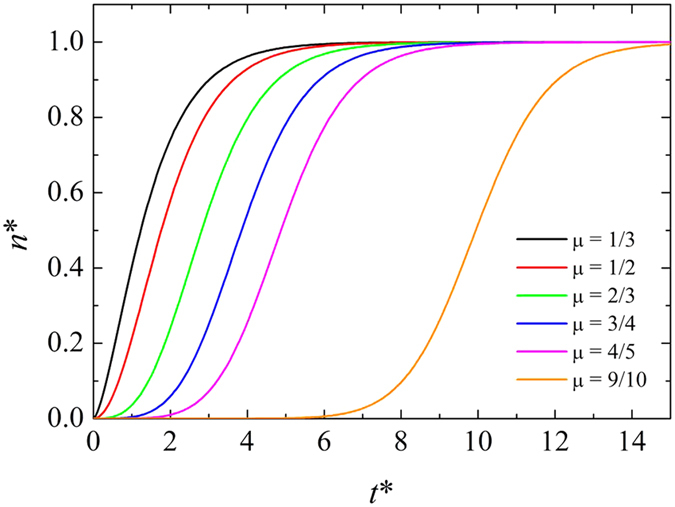
Solution of Eq. 11 for different values of the exponent μ.